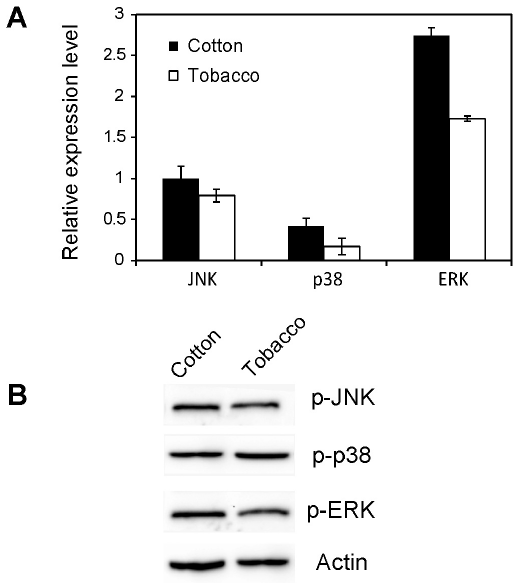
Figure 5. Effects of host shift on JNK, p38 and extracellular signal regulated kinase (ERK) in whiteflies. ( A ) Effect of host shift on mRNA level; ( B ) Effect of host shift on the phosphorylation level of JNK, p38 and ERK. Actin was used as a protein loading control. Each symbol and bar represents the mean ± SD ( n =